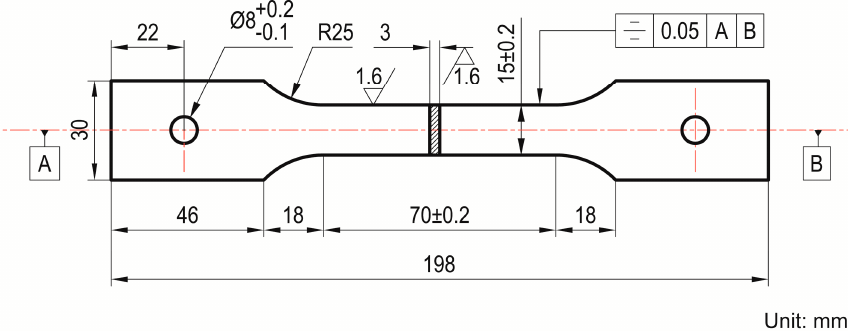
Figure 2. Pin-loaded sheet tensile test specimen with 70-mm gauge length.